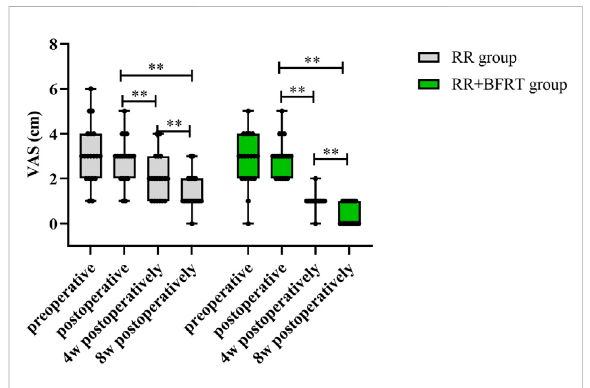
FIGURE 12 Intra-group comparison of Lysholm scores in RR group and RR + BFRT group. “ ** ” indicates a signi fi cant change ( p < 0.01). Values are presented as mean ± SD. RR Group: routine rehabilitation group; RR + BFRT Group: routine rehabilitation + blood fl ow restriction training